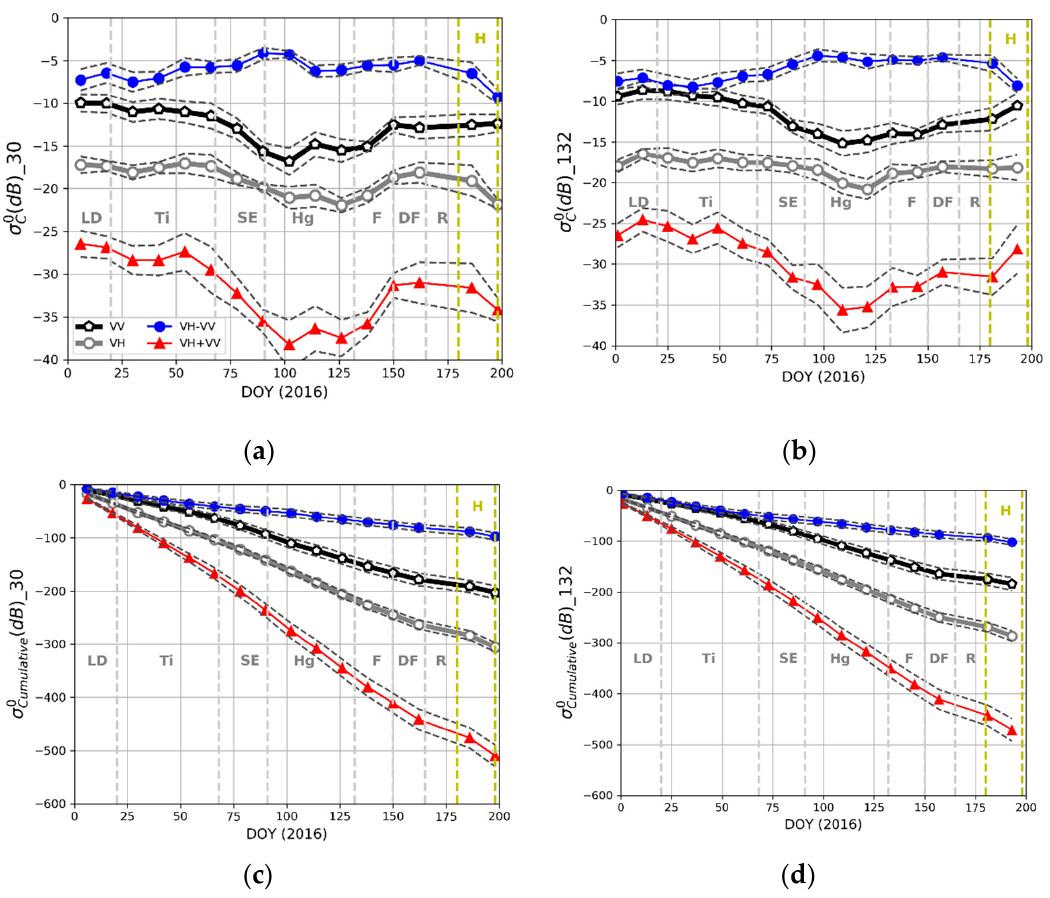
Figure 5. Mean temporal signatures of the S-1 backscattering coefficients (VV, VH, VH – VV, VH + VV) ( a ) and ( b ) and their cumulative values ( c ) and ( d ) for all fields. The vertical dashed gray lines represent the main phenological stages (their acronyms are specified in Table 1); the yellow lines represent the harvest period.